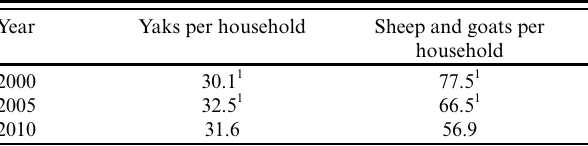
Table 5 . Comparison of livestock number in 2000, 2005, and 2010 in the study area.